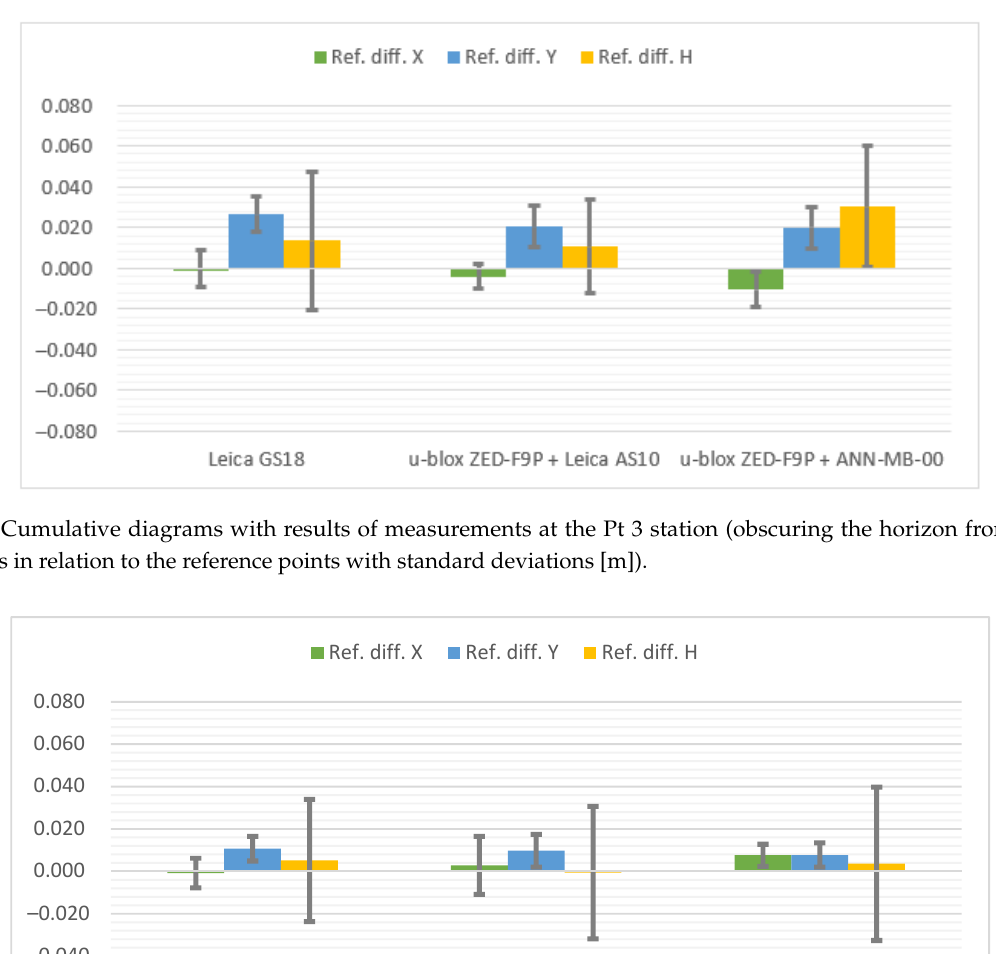
Figure 7. Cumulative diagrams with results of measurements at the Pt 2 station (horizon obscuration from the south; differences in relation to the reference points with standard deviations [m]).